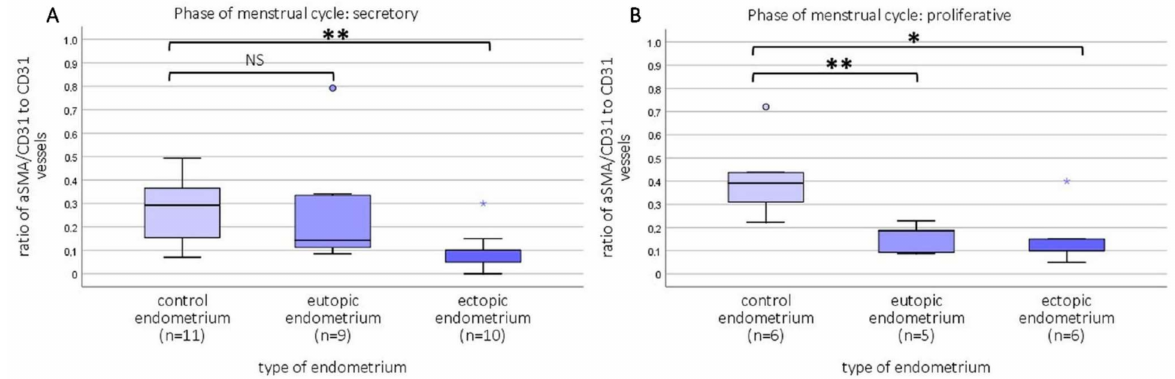
Figure 7. Boxplots of the ratio of the relative number of immature blood vessels, determined by the ratio of mature blood vessels that presented double immunostaining of CD31 and α -SMA to the total number blood vessels in the endometrium in the stroma in the secretory ( A ) and proliferative phase ( B ) of the menstrual cycle. In the secretory phase, the ratio of aSMA/CD31 vessels to CD31 vessels was lower in the ectopic endometrium than in the control endometrium ( p < 0.01). In the proliferative phase, the ratio of aSMA/CD31 vessels to CD31 vessels was lower compared to the control endometrium in both the eutopic ( p < 0.01) as well as the ectopic endometrium ( p < 0.05). Data shown as median ± range. NS: not significant; * significance p < 0.05; ** significance p <